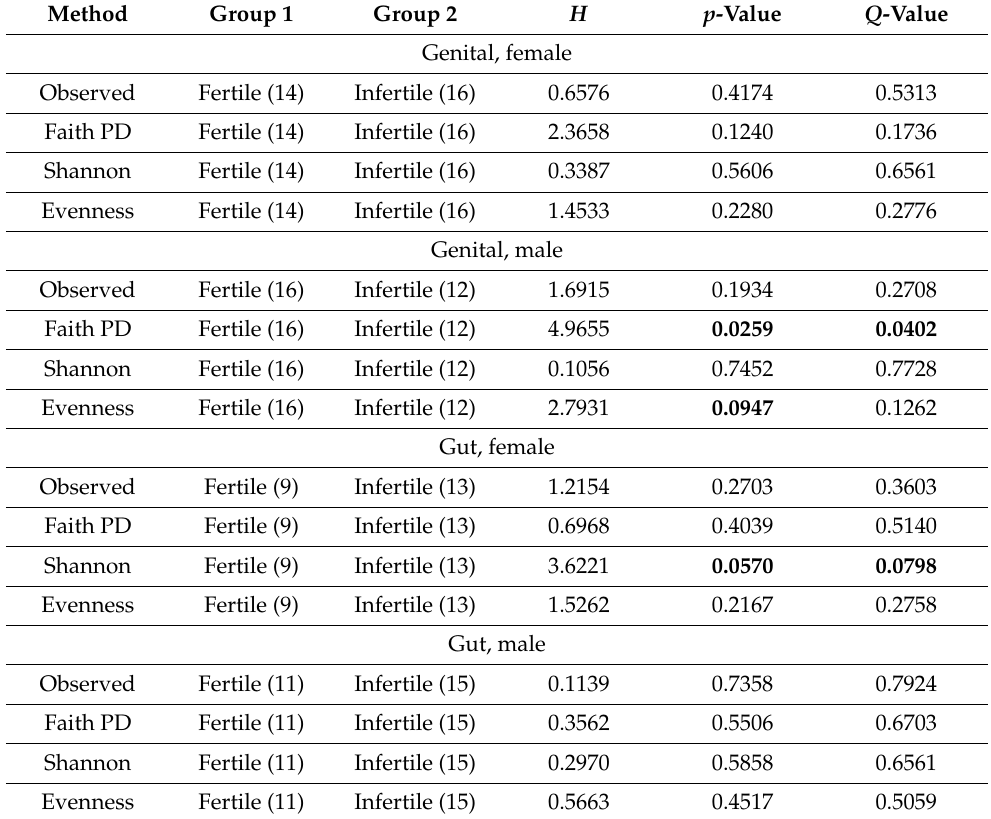
Table 3. Alpha-diversity differences in the studied groups. These differences were based on the non-parametric pairwise KW test. p - and Q -values < 0.1 are in bold (relaxed thresholds to detect more